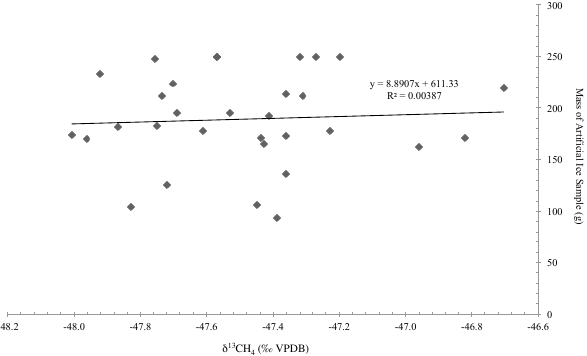
Fig. 1. Artificial reference ice samples δ 13 CH 4 value vs. sample size across three years. The data demonstrate good linearity across the range of artificial ice sample sizes. The dataset mean δ 13 CH 4 value is − 47.51 ± 0.29‰ (1 σ ; n =32; methane content varying be- tween ∼